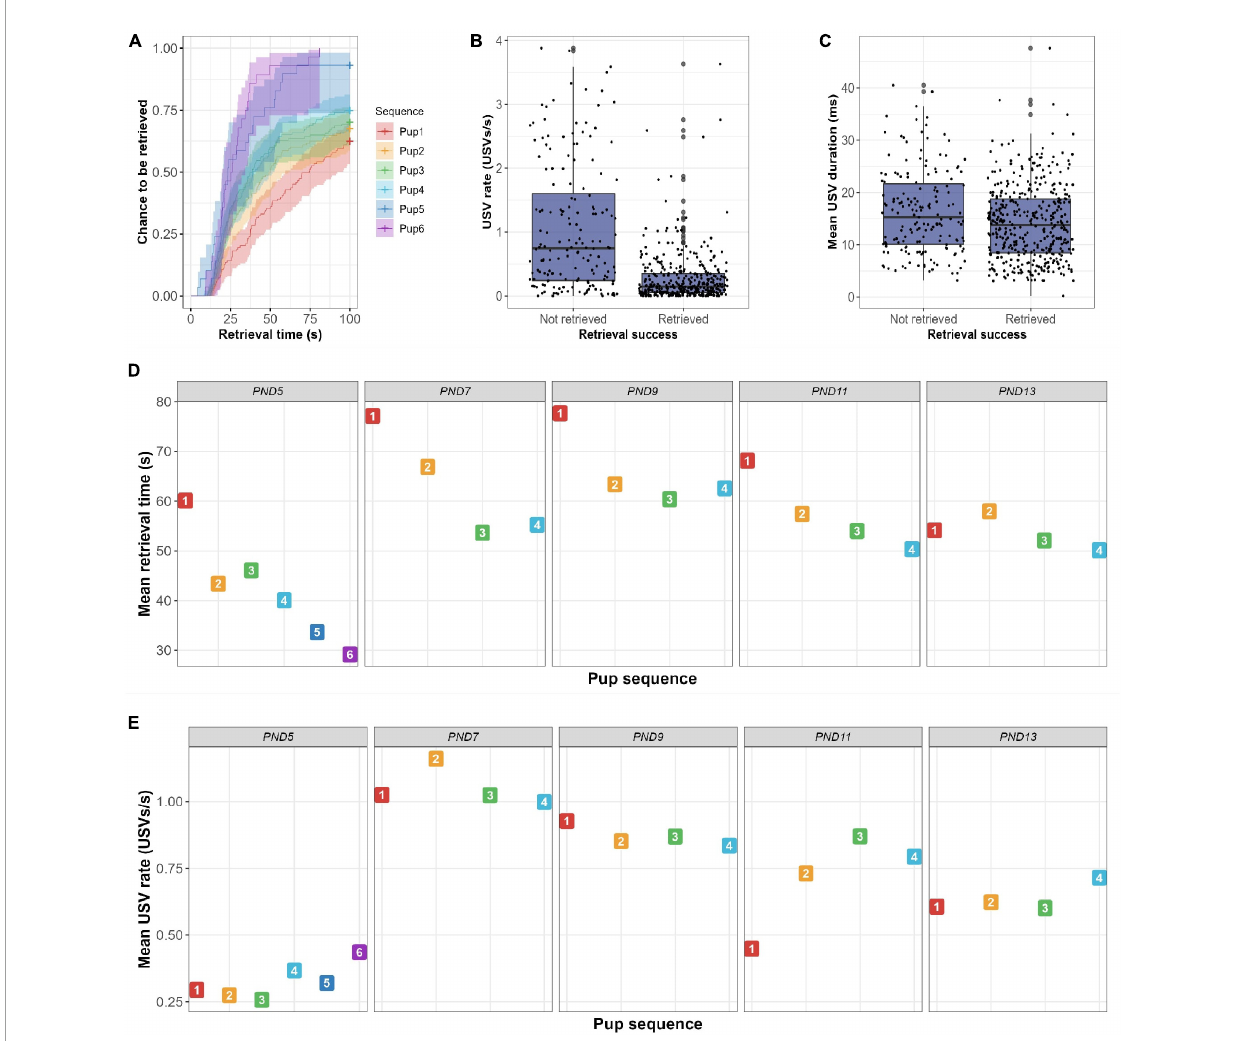
FIGURE4 Results of bidirectionality analysis. (A) Survival plot representing the estimated probability to be retrieved over time in the PRT per maternal trial. Both retrieval time and chance to be retrieved increased as the maternal trial number increased, suggesting a maternal learning effect. (B) Boxplot showing the number of USVs emitted per second when pups are either not retrieved or retrieved. Pups with a higher USV rate had a higher probability not to be retrieved ( p < 0.001). (C) Boxplot showing the mean duration of USVs per pup when pups are either not retrieved or retrieved. Pups with a higher mean USV duration had an increased chance not to be retrieved ( p < 0.001). (D) Mean plot showing the mean retrieval time per maternal trial per day. Although retrieval time decreases significantly for trials within days ( p < 0.001), the learning effect was not significant between days ( p = 0.22). (E) Mean plot showing the mean USV rate per maternal trial sequence per day. USV rate was not affected by repeated trials ( p = 0.59), whereas test day significantly did ( p =